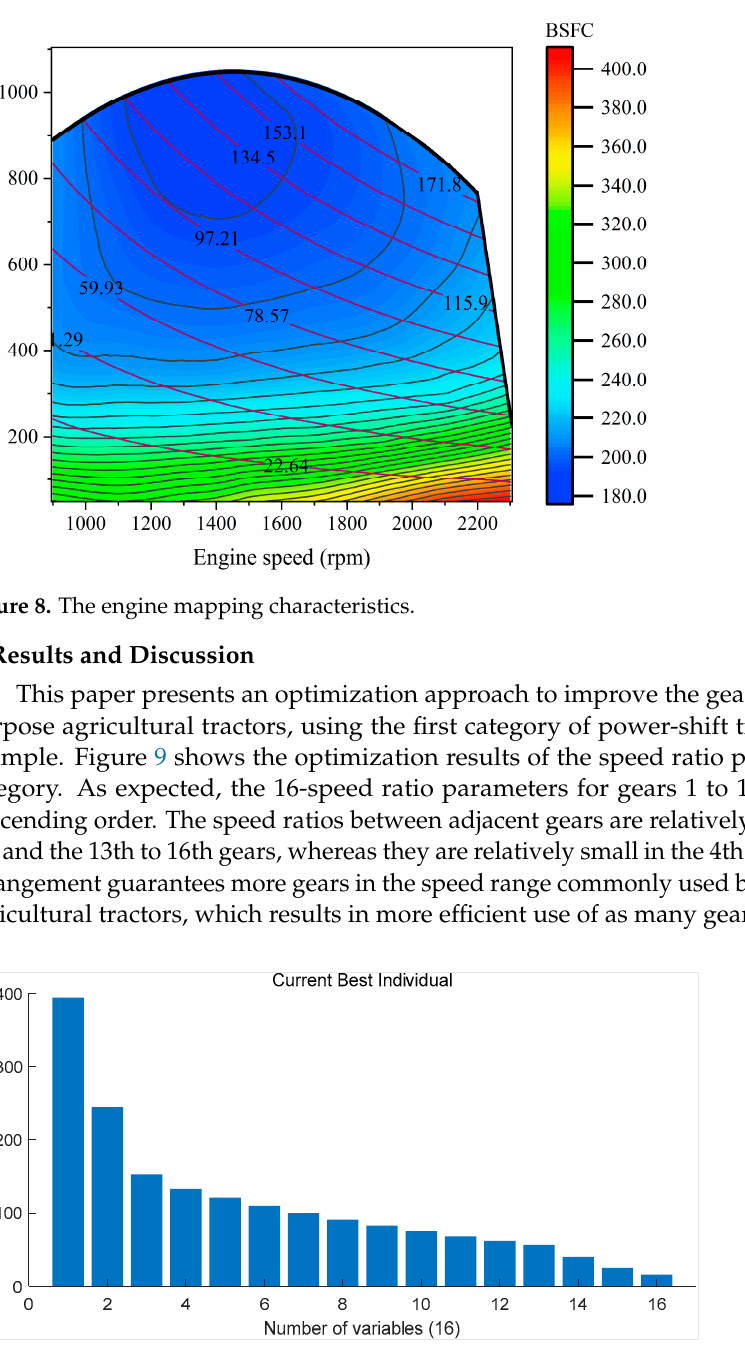
Figure 9. Optimization results based on genetic algorithm for the first